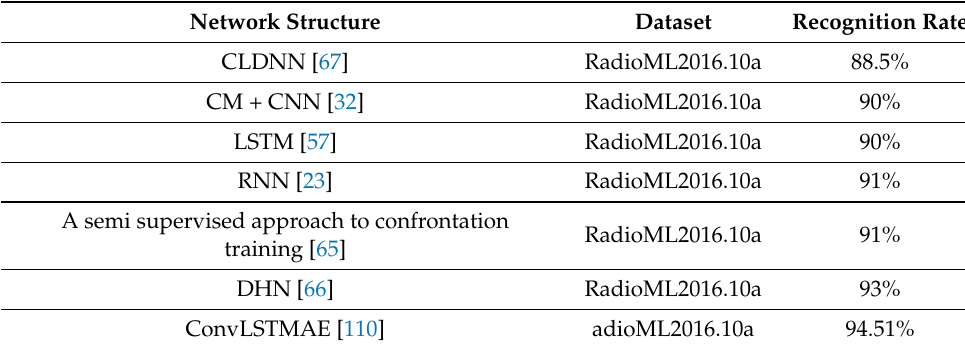
Table 14. Accuracy comparison of existing classical